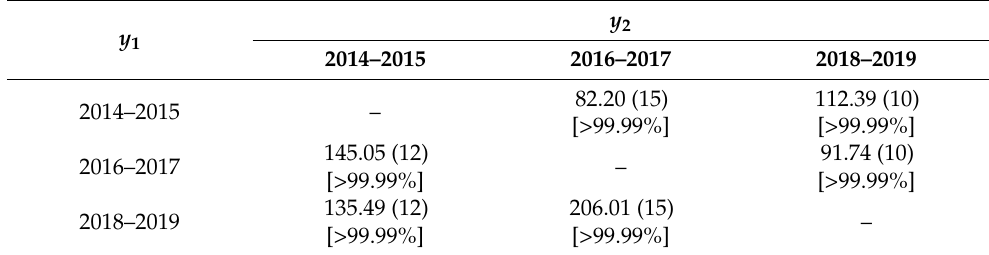
Table 4. Results of LRT across year periods (two-vehicle G2 rear-end crash models). y 1